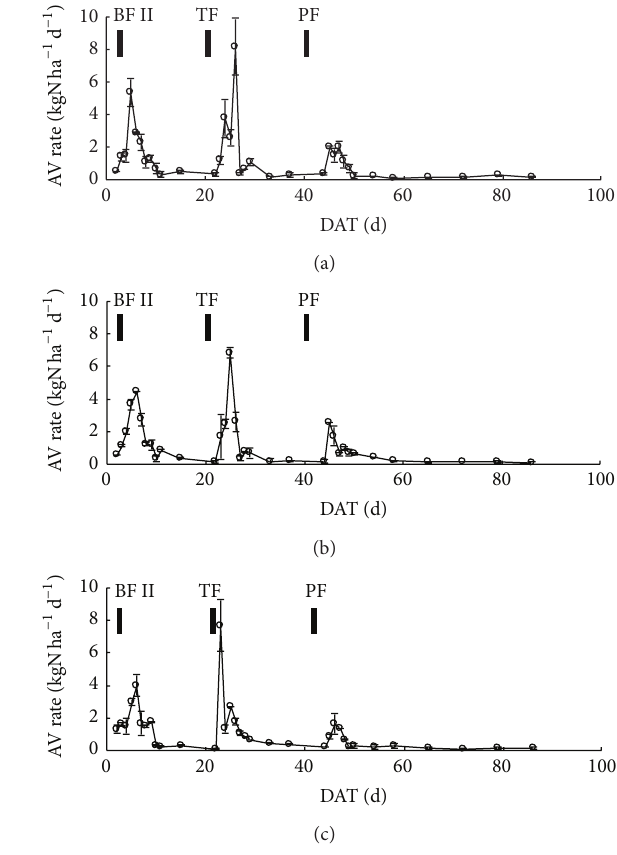
Figure 4: Ammonia volatilization rates from (a) CWT1, (b) CWT2, and (c)